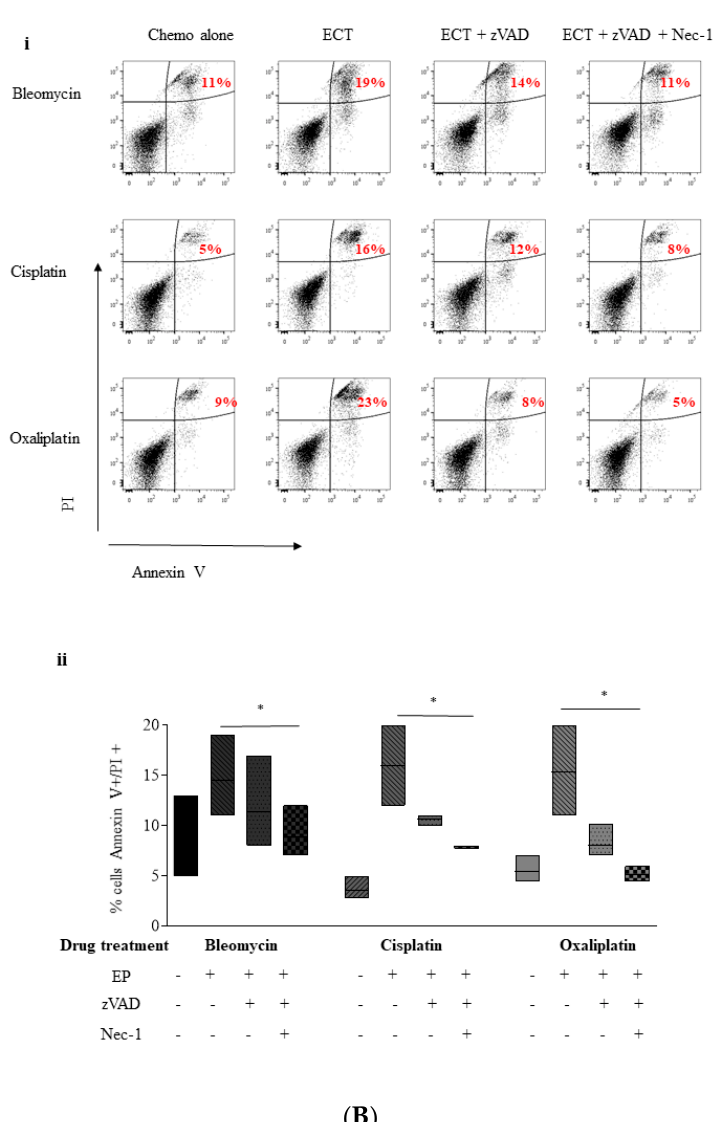
Figure 4. zVAD and Necrostatin-1 pre-treatment reduces the Annexin V positive, PI positive cell population following ECT. (PANC-1 cells ( A ) or Pan02 cells ( B ) were either treated with chemotherapy or electroporated in the presence of chemotherapy, with 25 μ M zVAD and/or 10 μ M Nec-1. PANC-1 cells were treated with 0.1 μ g/mL Bleomycin, 0.1 μ g/mL Cisplatin or 3 μ g/mL Oxaliplatin whereas Pan02 cells were treated with 0.1 μ g/mL Bleomycin, 0.5 μ g/mL Cisplatin or 1 μ g/mL Oxaliplatin. Cells were subsequently reseeded in 6 wells plates at a density of 0.5 × 10 6 cells/mL for PANC-1 or 125 × 10 3 cells/mL for Pan02 in a total volume of 2 mL. After 24 h, all cells (both viable and non-viable) were stained using Annexin V and PI followed by detection using flow cytometry. The experiment was repeated at least three times and the data from one representative experiment is presented as a dot plot (i). The Annexin V positive, PI positive (double-positive) percentage of cells is indicated beside the gated cells in red. The double-positive percentage data from three independent experiments (minimum to maximum) is also presented as floating bar graphs (ii)—with the median integrated intensity relative to EP buffer alone denoted with a line. * statistically significant differences in percentage double-positive cells between the ECT and ECT in the presence of both zVAD and Nec-1 is shown, * p = 0.05.